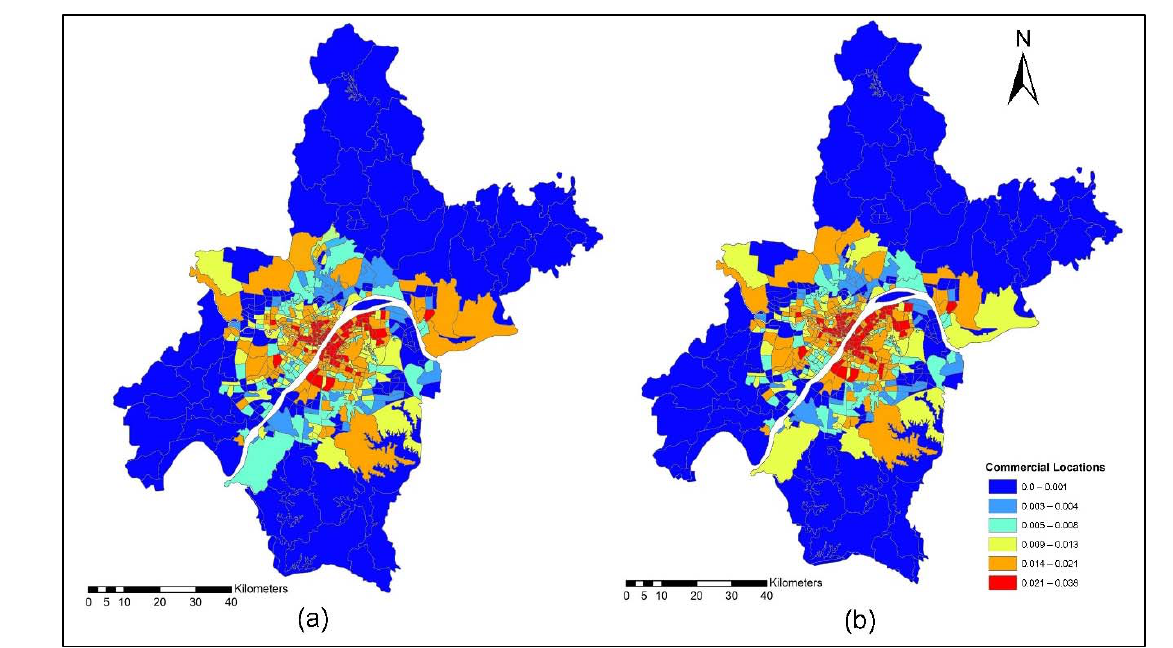
Figure 18. ( a , b ) ISE estimated commercial locations: ( a ) during off-peak for the year 2012; ( b ) during off-peak for the year 2015.